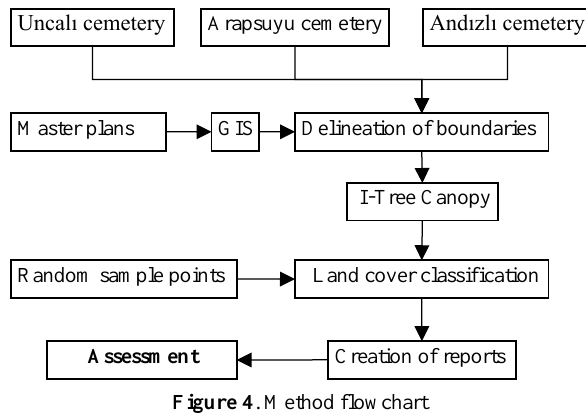
Figure 4 . Method flowchart